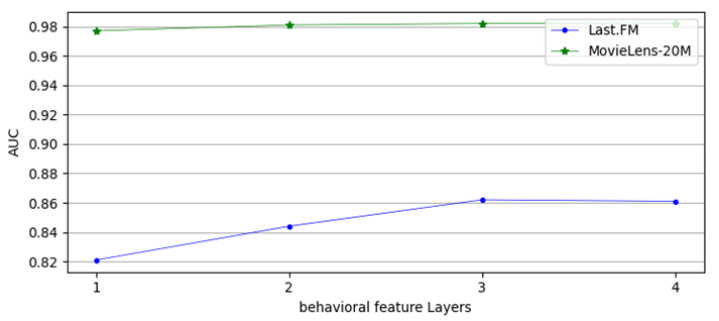
Figure 4. Influence of behavioral feature layers on